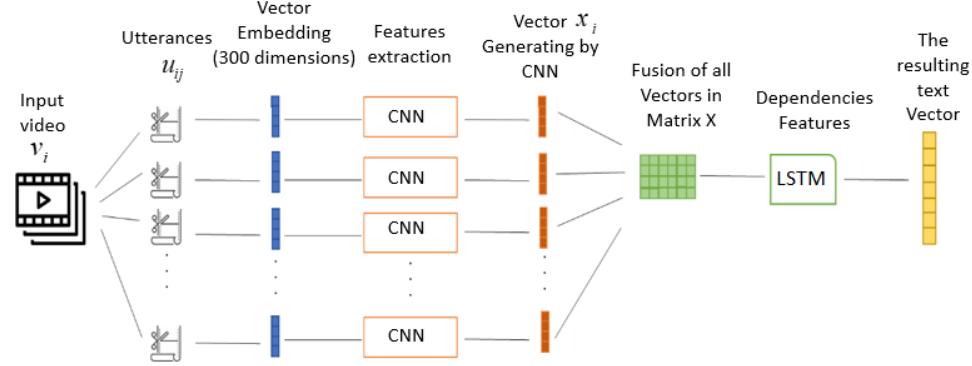
Figure 5. The text vector extraction